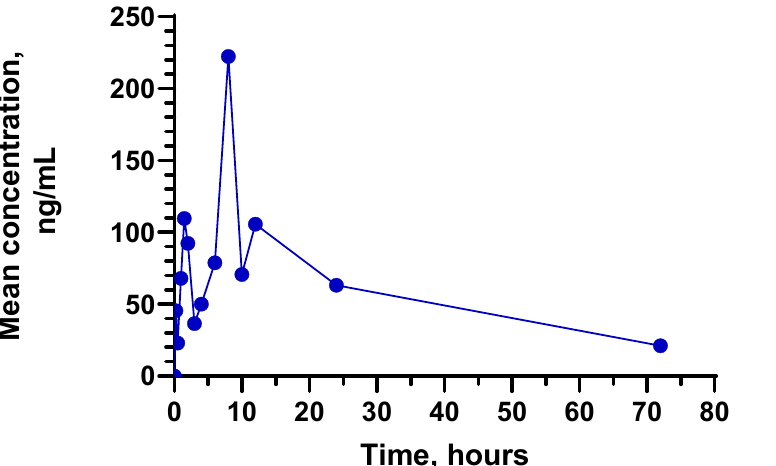
Figure 4. The mean pharmacokinetics curve of conjugate PSMA-Abi administered at a dose 1000 mg/kg to rats. Table 2. Pharmacokinetic parameters of conjugate PSMA-Abi estimated in rats after single peroral administration at a dose 1000 mg/kg as 1% starch suspension formulation.